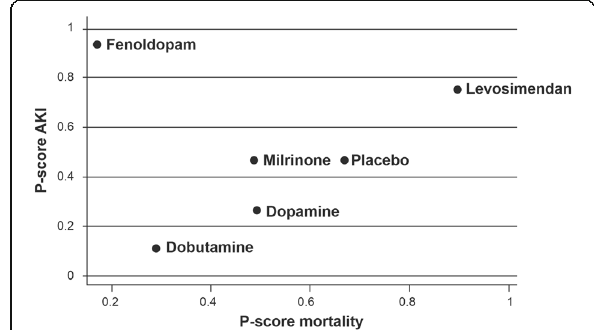
Fig. 4 Mortality data and the incidence of acute kidney injury (AKI) reported for 3641 patients in a cardiac surgery network analysis. P- scores ranking plot showing mortality and AKI associated with interventions. Treatments with better efficacy should be in the upper-right-hand corner of the graph. Figure drawn freely from the data reported by Chen et al.